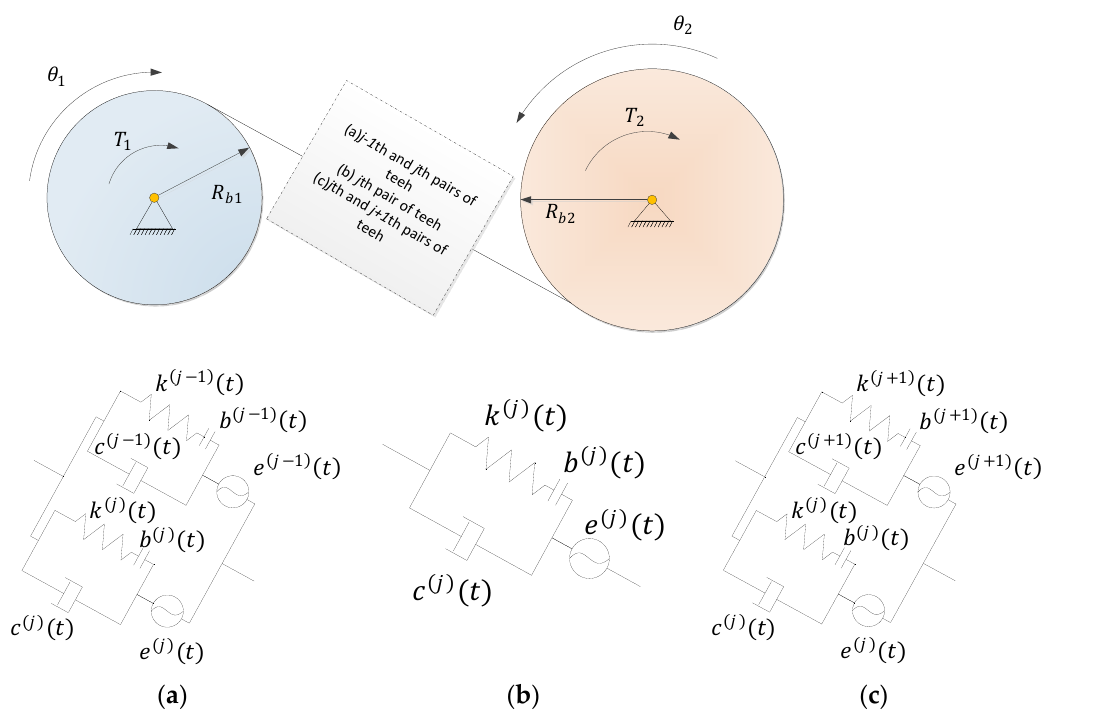
Figure 2. Dynamic model for gear system considering the meshing state of multiple pairs of teeth: ( a ) 𝑗 − 1th and 𝑗th pairs of teeth; ( b ) 𝑗th pair of teeth; ( c ) 𝑗th and 𝑗 + 1th pairs of teeth.